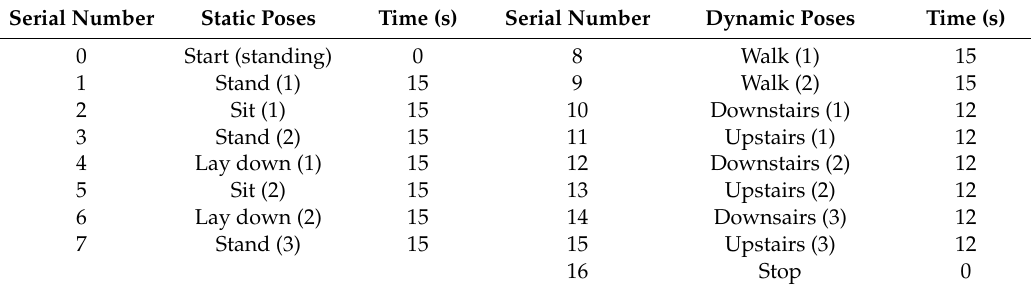
Table 1. Human activity recognition experiment protocol.